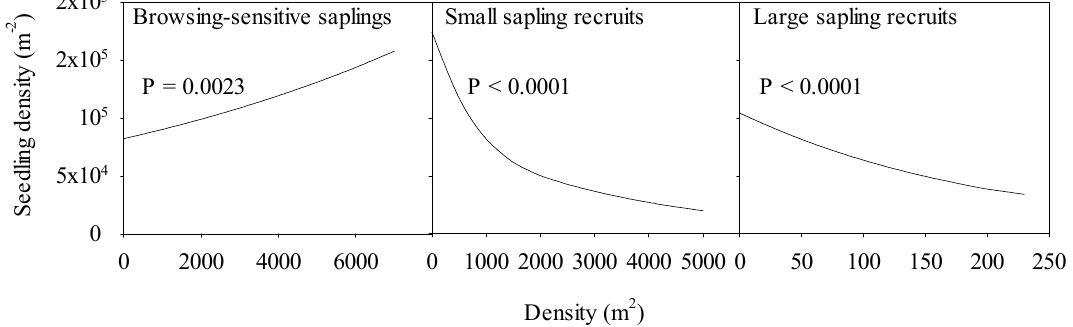
Figure 6. Estimates of seedling density from a negative binomial model including all three larger regeneration strata as predictors: Prediction profiles are shown for each stratum with other factor sets and their mean values, i.e., browsing-sensitive saplings = 1059 ha − 1 , small sapling recruits = 848.5 ha 1 , and large sapling recruits = 28 ha − 1 . Effects of poletimber and sawtimber density were insignificant ( p > 0.10) in preliminary models and, thus, were not included in this final model.